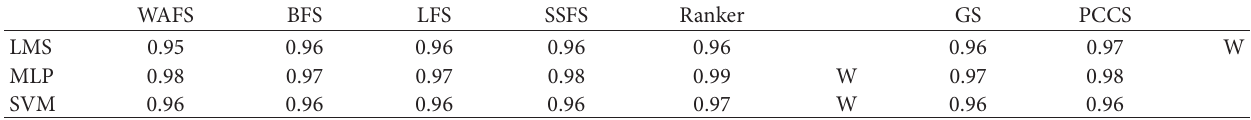
Table 2: Achieved CC after applying various wrapper selection methods on LMS, MLP, and SVM. WAFS